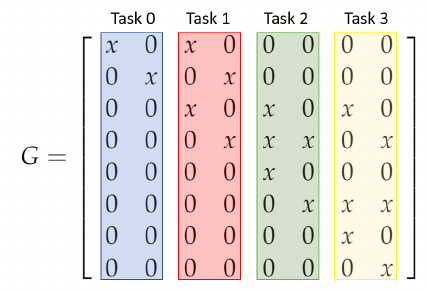
Figure 2. Distribution of columns of matrix G on four